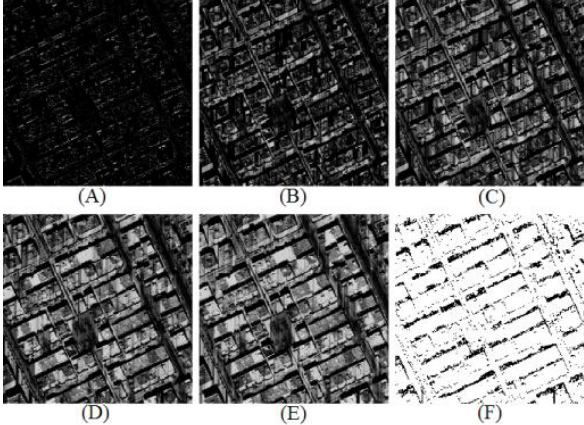
Figure 2. Subtraction of main image from reconstructed image by a SE with 90 degree direction and a scale of, A. 5×5, B. 10×10, C. 15×15, D. 20×20, E. 25×25. F. Summation of A to E